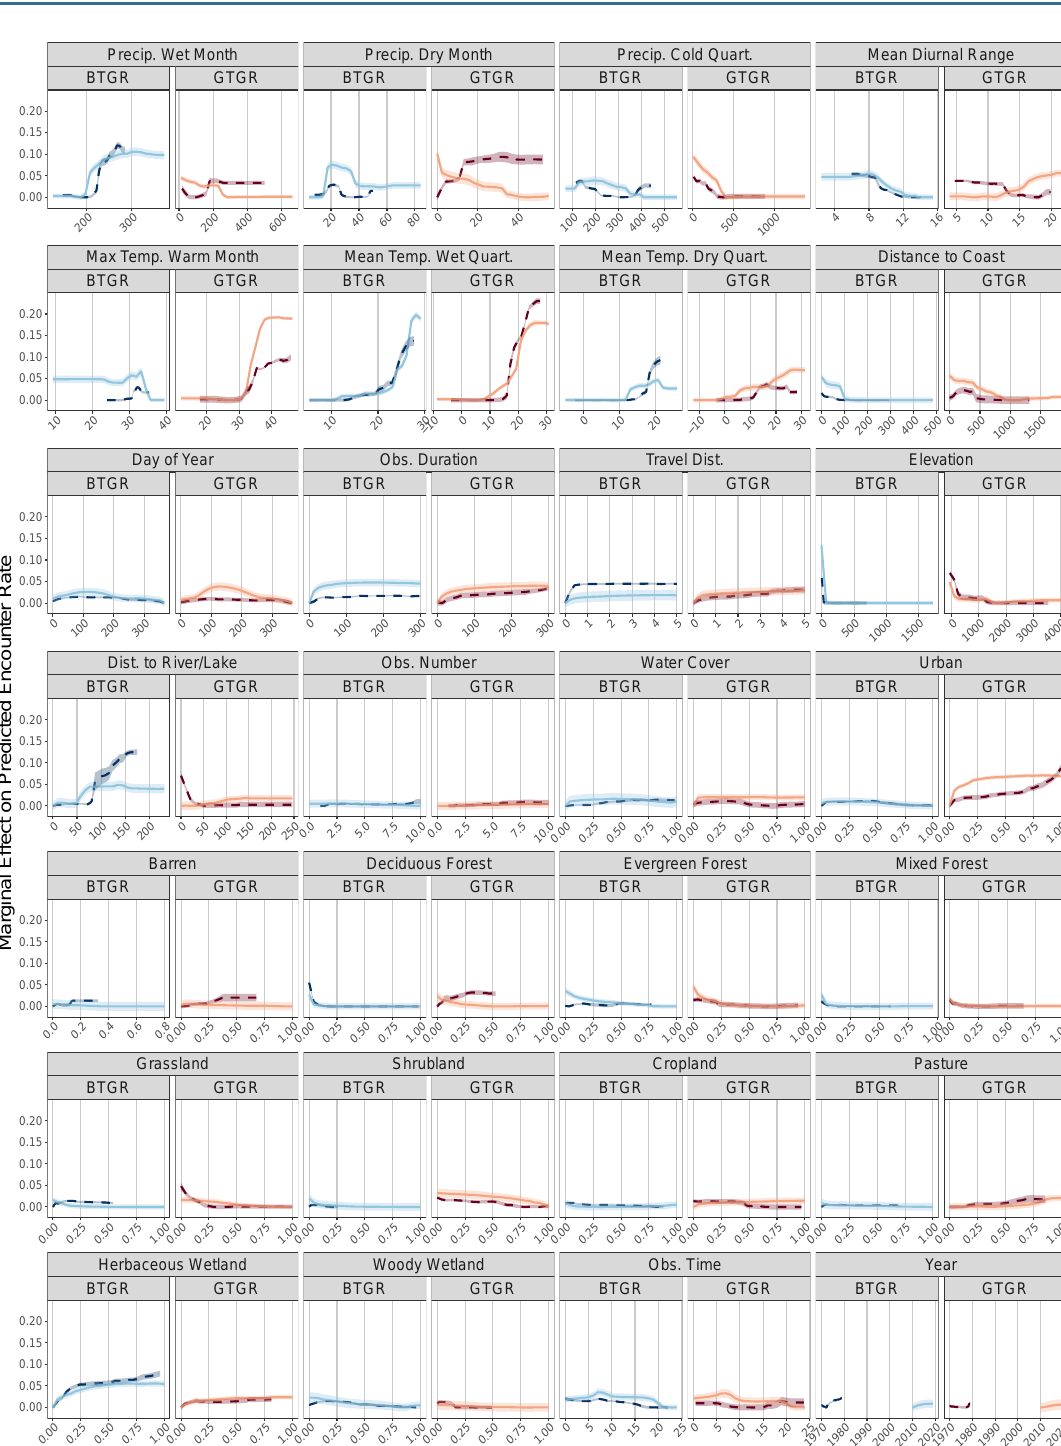
Supplementary Figure 3 – Partial dependence curves for environmental predictors across all mod- els (boat-tailed grackle: BTGR; great-tailed grackle: GTGR). The curves represent how changing each environmental predictor changes the encounter rate for the modeled species. The historic models are represented by the darker dashed lines and the current models are represented by the lighter solid lines. Shaded regions indicate one standard deviation. The differences between the historic and current models for each species present how the species niche has changed based on our